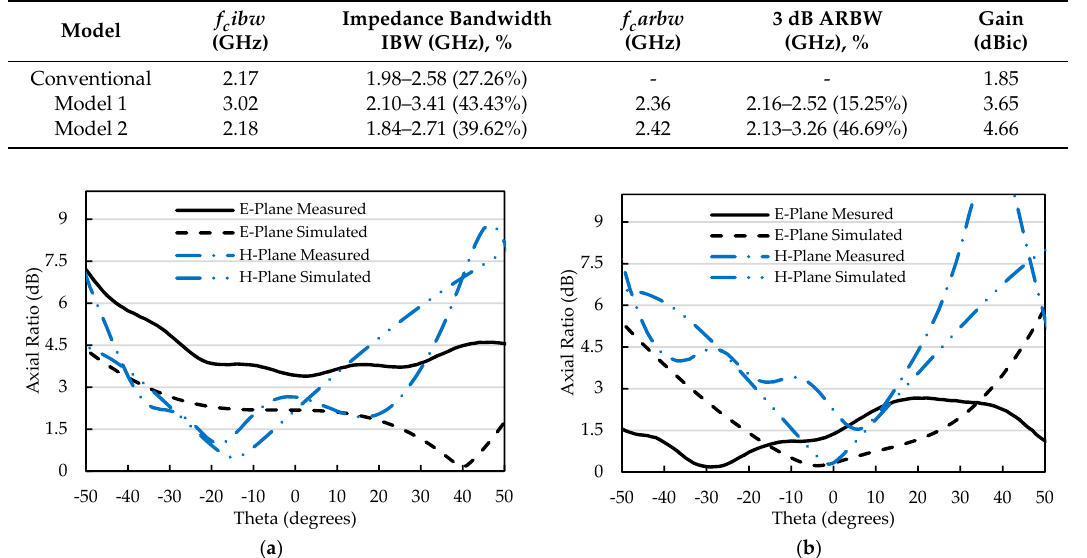
Figure 6. The measured and the simulated axial ratio (AR) vs. theta ( 𝜃 ) at frequencies of ( a ) 2.2 GHz and ( b ) 2.4 GHz.